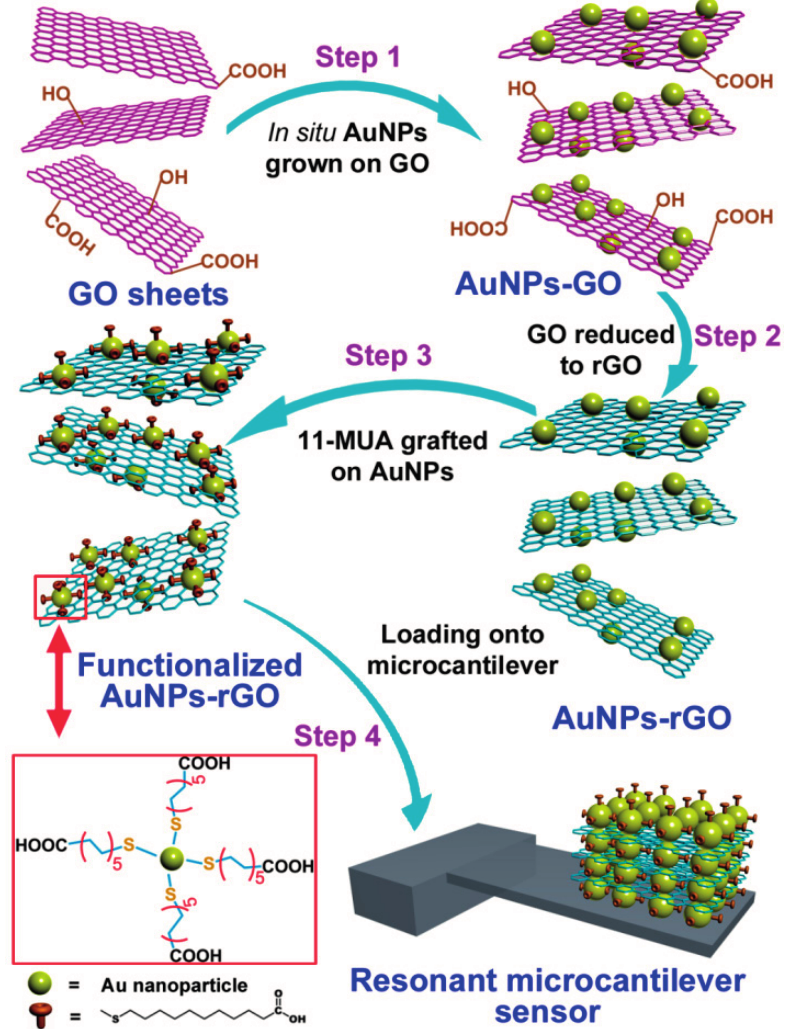
Figure 23. Schematic of the process for preparing functionalized AuNPs-rGO and constructing the nanoporous material on a cantilever. Reprinted with permission from